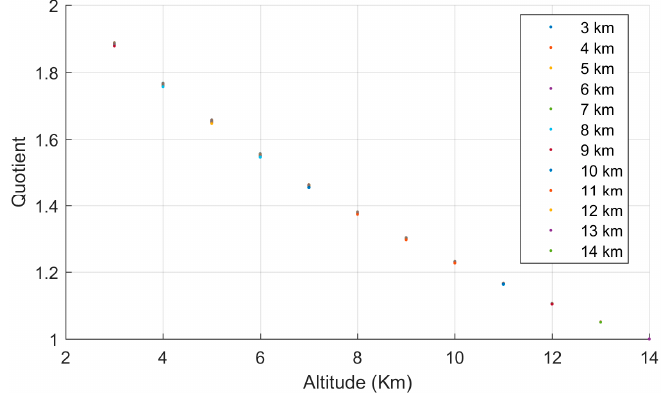
Figure 9. Ratio between range bias at an altitude and bias at reference altitude (14,000 m) for the same slant range as a function of